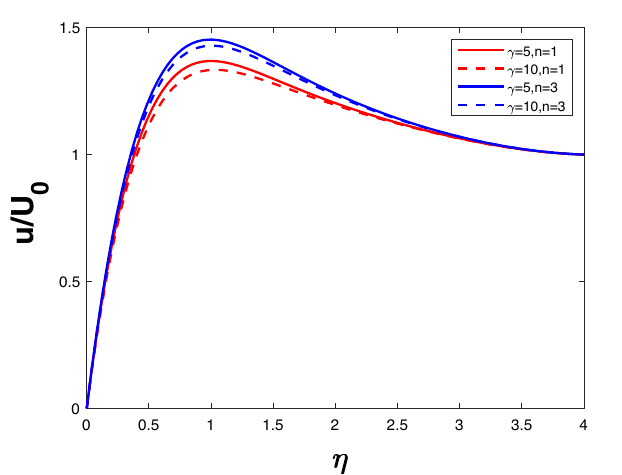
Figure 12. Velocity profile for various γ .